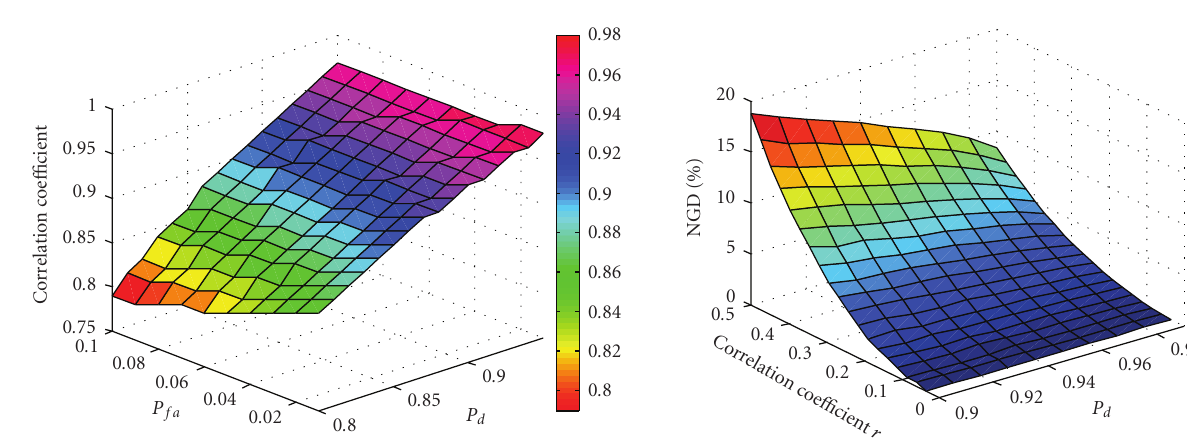
Figure 6: NGD for di ff erent values of correlation coe ffi cient and P d for P fa = 0 .